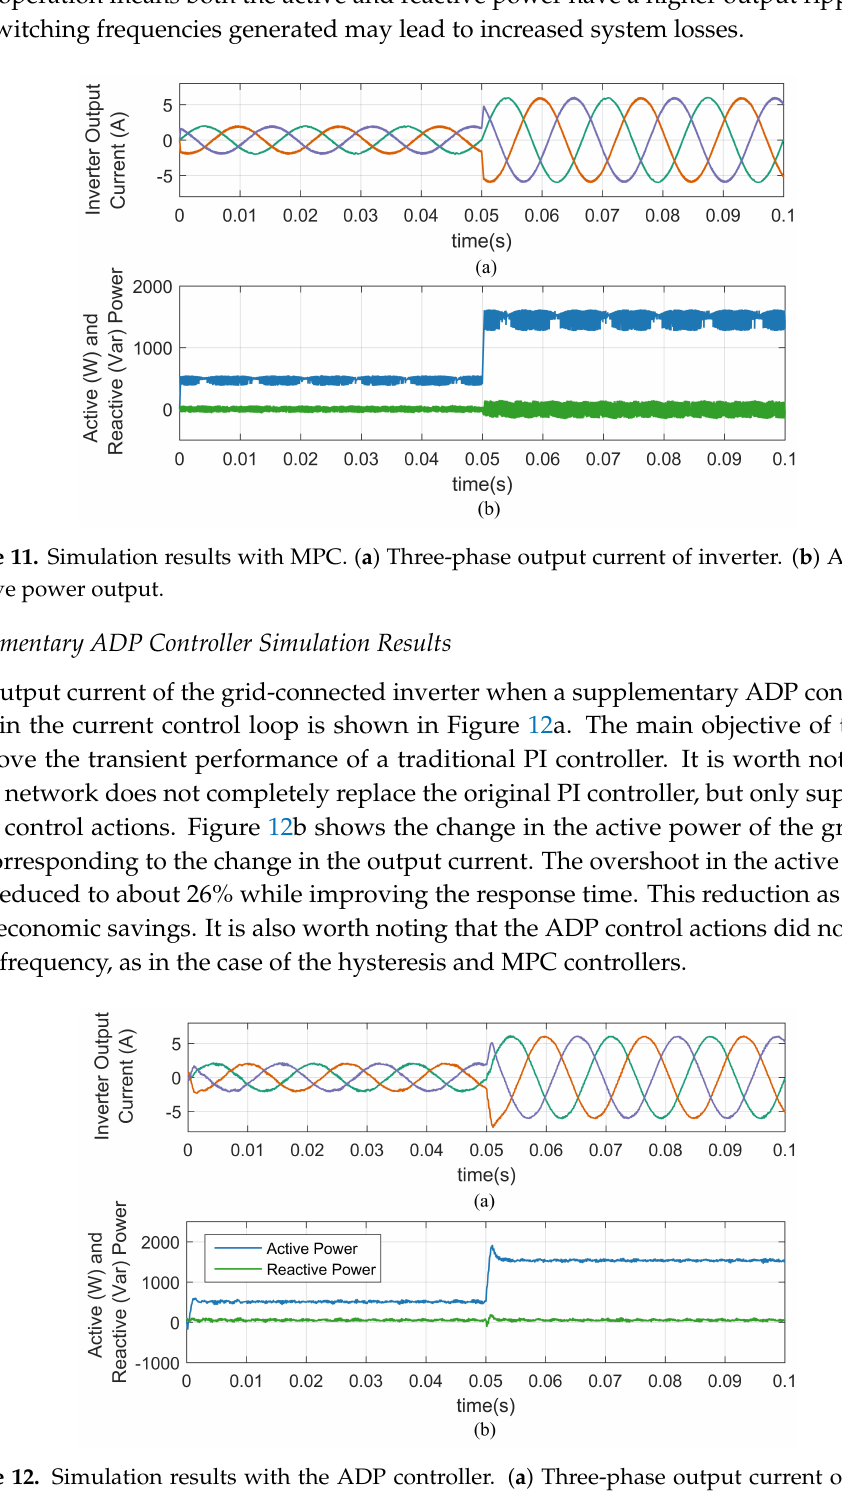
Figure 12. Simulation results with the ADP controller. ( a ) Three-phase output current of inverter. ( b ) Active and reactive power